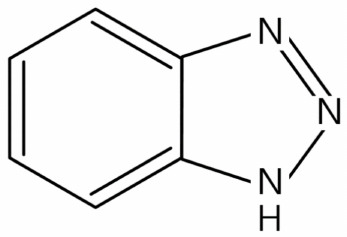
Figure 1. Molecular structure of benzotriazole.